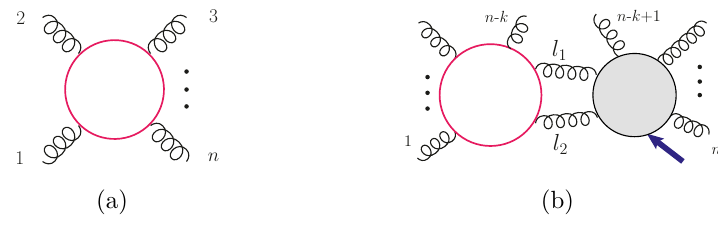
Figure 17. Color factors of the one- and two-loop